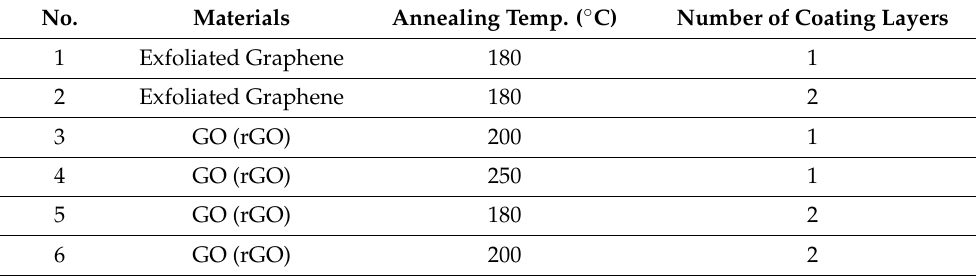
Table 1. Fabrication details of the six sensors constituting the proposed electronic